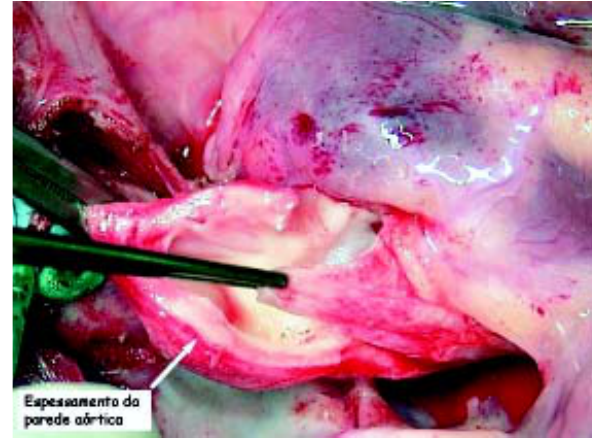
Fig. 3 – Imagem de “y” invertido após incisões nos seios de da estenose (seta)